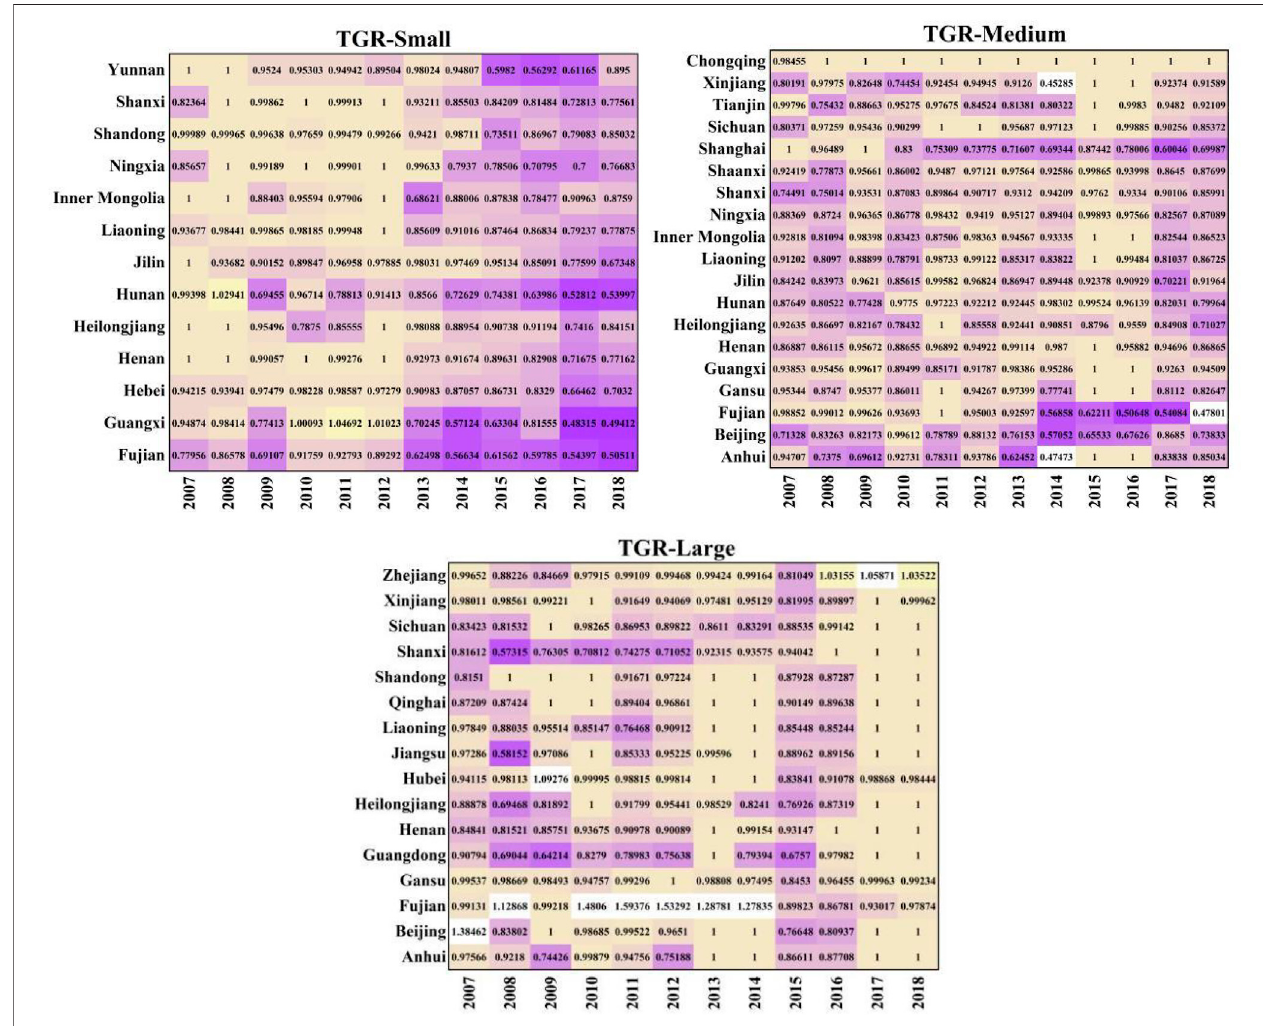
FIGURE 7 | Three-sized TGR from 2007 to